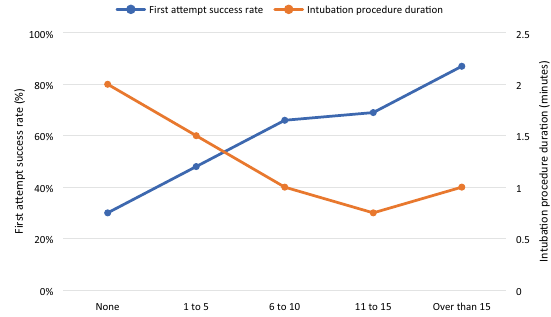
Fig. 1 First attempt success rate and intubation procedure duration according to previous experience in videolaryngoscopy P‑186 Impact of tracheostomy timing on prognosis in intensive care unit Hatem Ghadhoune 1 , Jihene Guissouma 1 , Sourour Belhaj Youssef